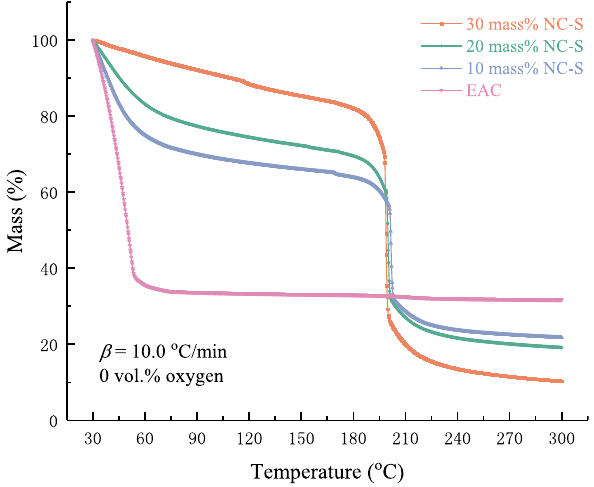
Figure 1. TG curves of EAC and different concentrations of NC-S in an oxygen-free